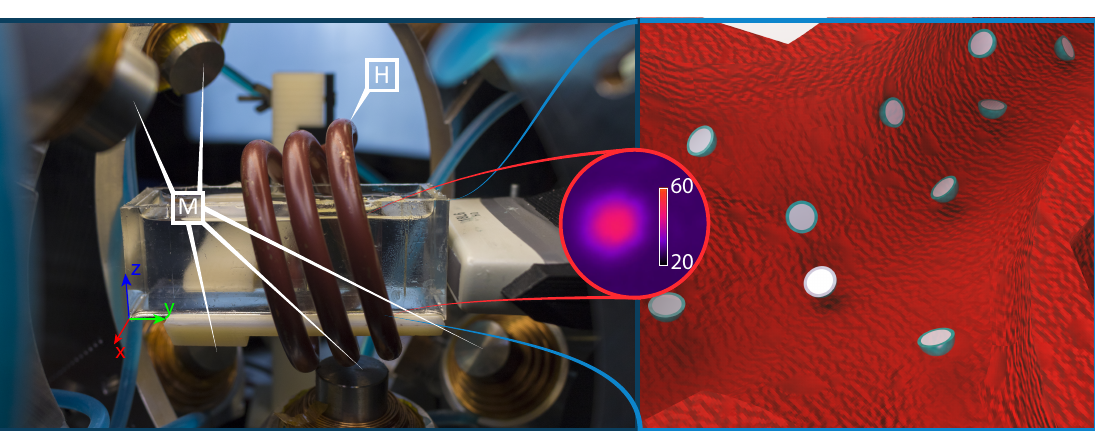
Figure 2. The electromagnetic setup. The nine metal-core electromagnets generating quasi-static fields of up to 10 mT while allowing access to objects smaller than a sphere. A linear stage is used to move the ultrasound probe Finally, the liquid-cooled high frequency coil inset ) A representative B-mode ultrasound image. The position of the microrobot is marked by a green square. Due to diffraction, artifacts, and noise the footprint of microrobot in the ultrasound image is significantly larger than its real size. ( Bottom-right inset ) A coated microrobot navigating the phantom of vascular vessels (outlined by the colored dashed